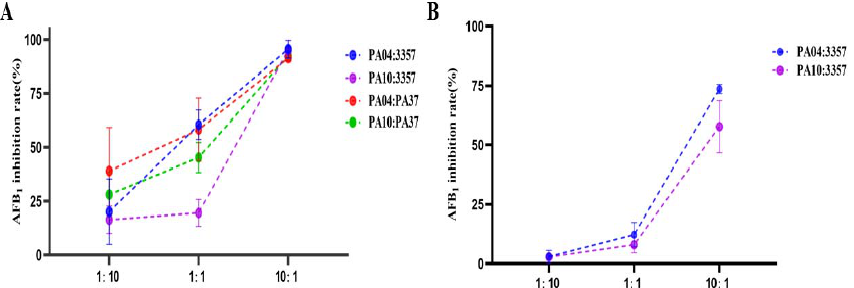
Figure 5. Inhibition of AFB 1 biosynthesis by NRRL 3357 or PA37 with co-inoculation of different proportions of atoxigenic strains on peanuts at 30 ◦ C for seven days ( A ). Inhibition of AFB 1 production by NRRL 3357 with different inoculation ratios cultured on PDA at 30 ◦ C, 10 d ( B ).